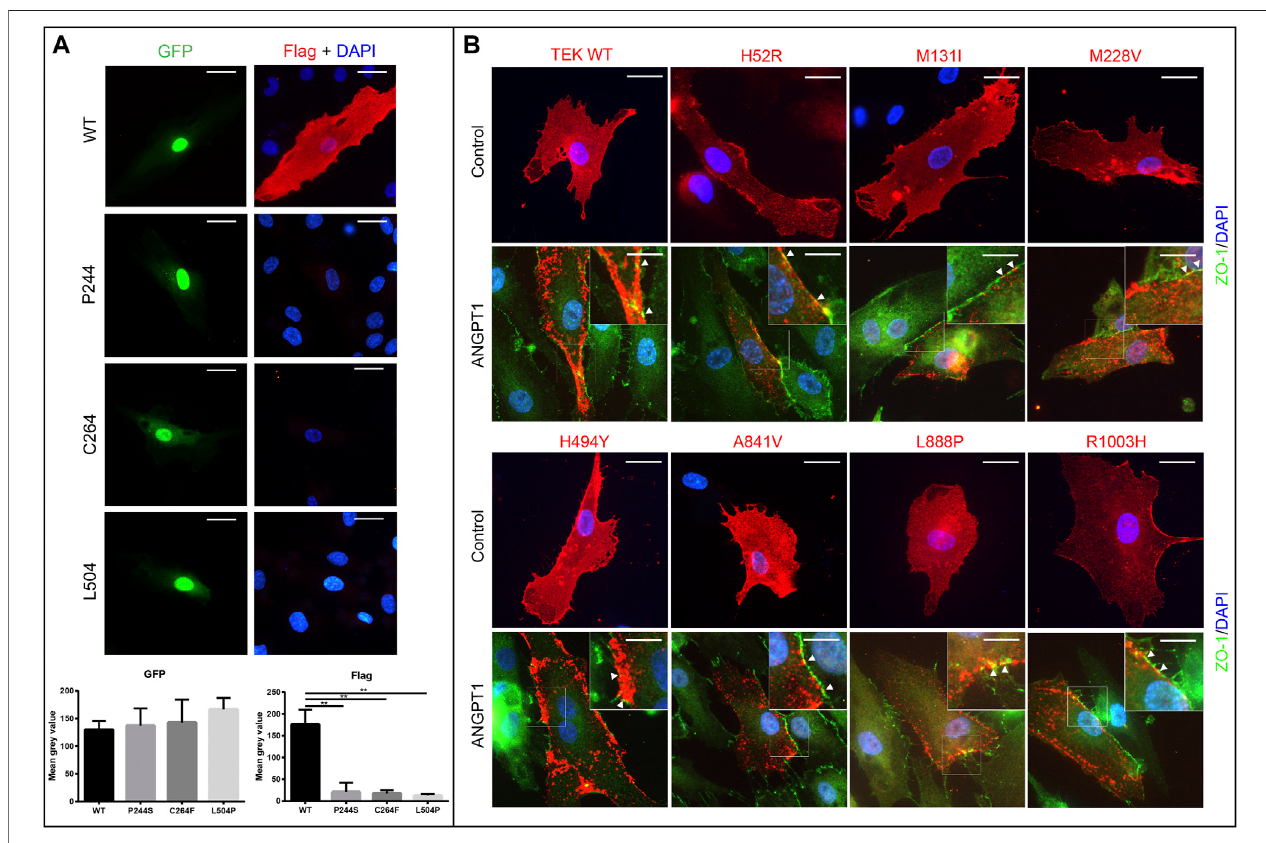
FIGURE 4 | Expression and ligand responsiveness of TEK variants (A) . Expression of p.P244S, p.C264F, and p.L504P were greatly decreased in HUVECs. GFP (green)signalsindicatedcellsweresuccessfullytransfected.Wild-typeTie2(anti-Flag,red)wasdiffuselydistributedincellularmembraneofquiescentHUVECs( fi rstrow). However, Flag signals for three loss-of-function variants were notably reduced. Scale bars indicate 25 μ m. (B) After stimulation by Angiopoietin-1 for 30 min (lower panel) ,TEK proteins wererelocated tocell – cell junctionsasindicatedby anti-ZO-1 (green).Nucleiwerestained byDAPI(blue). Scale bars indicate 25 μ m inupper panel and 12.5 μ m in lower panel for magni fi ed images. Pictures presented were representative of four biological